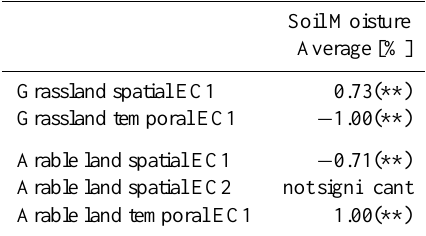
Table 3. Pearson correlation coefficients between ECs and the soil moisture average from each measuring